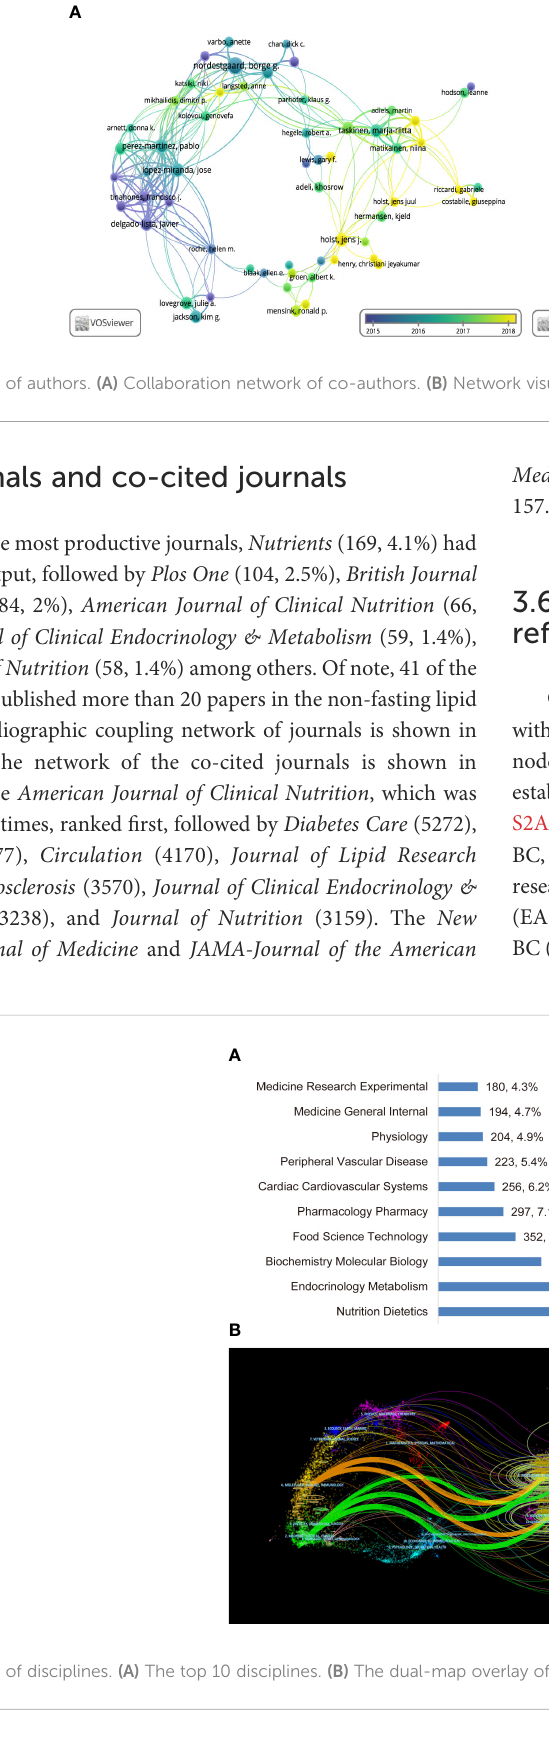
FIGURE 5 Visualization of disciplines. (A) The top 10 disciplines. (B) The dual-map overlay of